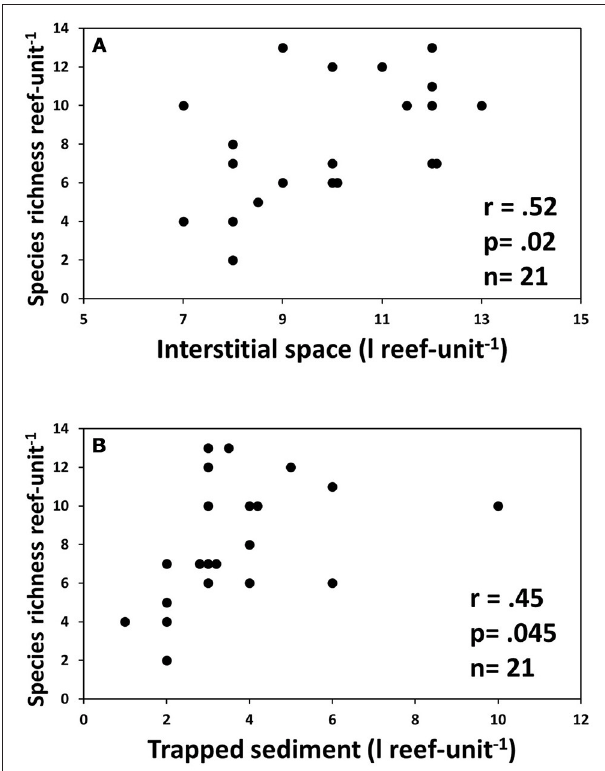
FIGURE 7 | Correlation between abiotic reef properties and species richness. (A) Volume of interstitial space within each reef unit; (B) Amount of sediment trapped by reef